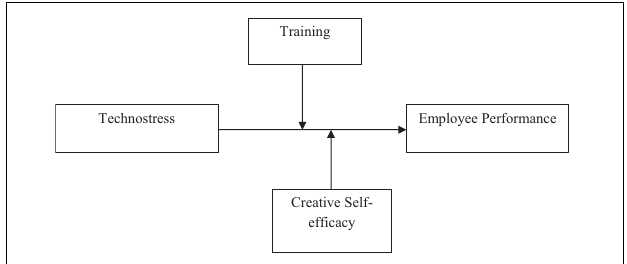
FIGURE 1 | Research